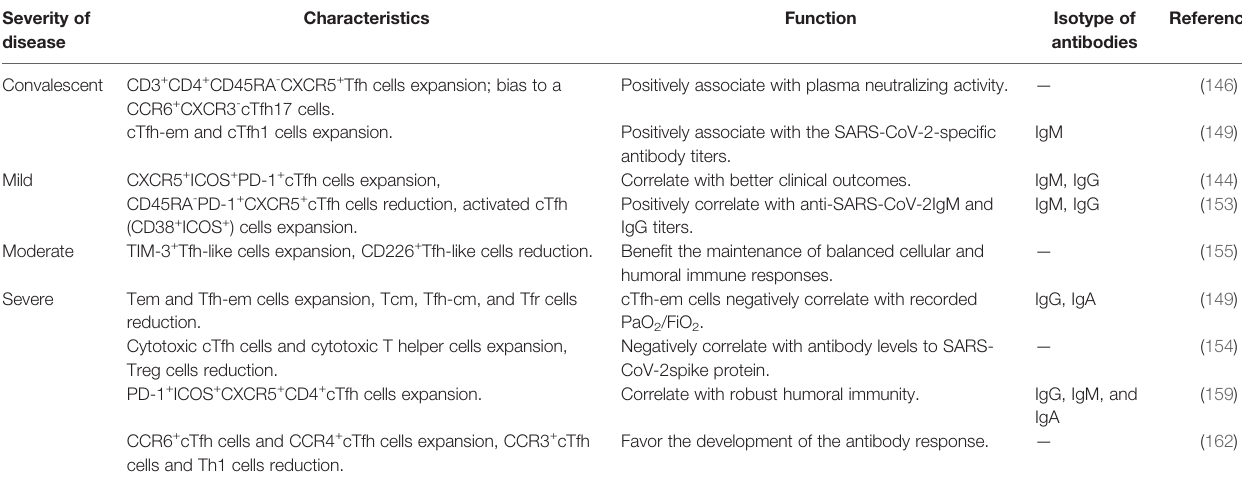
TABLE 2 | Characteristics and function of Tfh cells in COVID-19